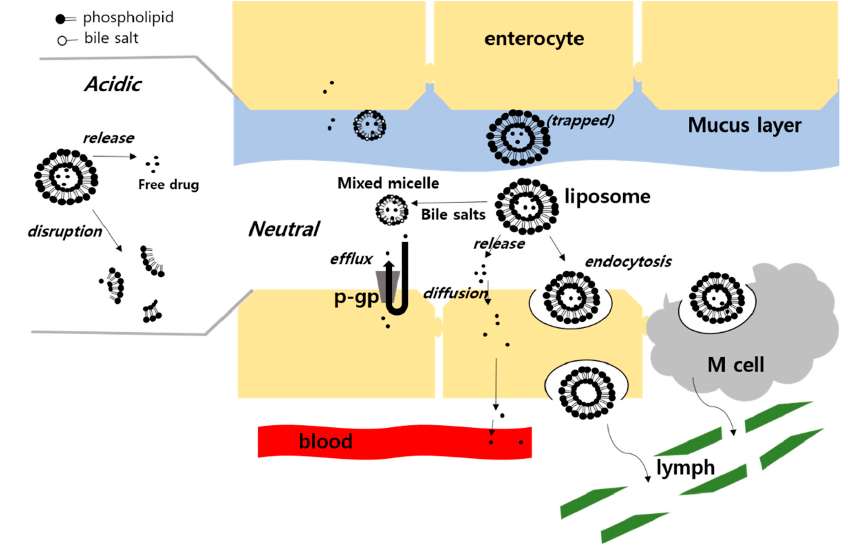
Figure 6. Proposed fate and absorption mechanisms of water-insoluble drugs delivered by liposomes